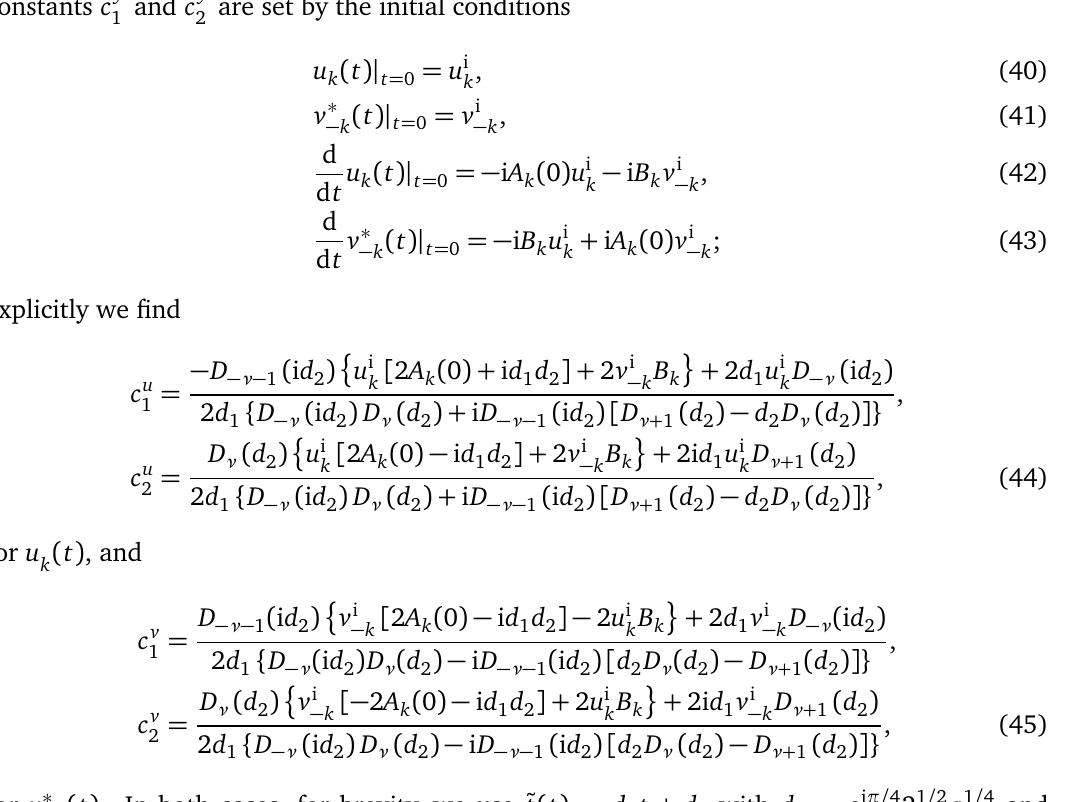
after different finite-time quenches with k → n s for τ → 0 irrespective of the quench k k